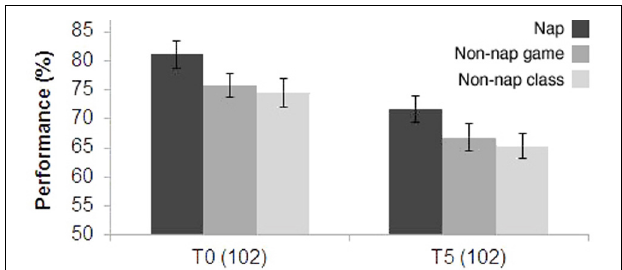
FIGURE 3 | Experiment II—Test performance immediately after the lecture (T0), and 5 days later (T5). Nap ( N = 32), non-nap groups for game class ( N = 41), and non-nap groups for regular class ( N = 29).